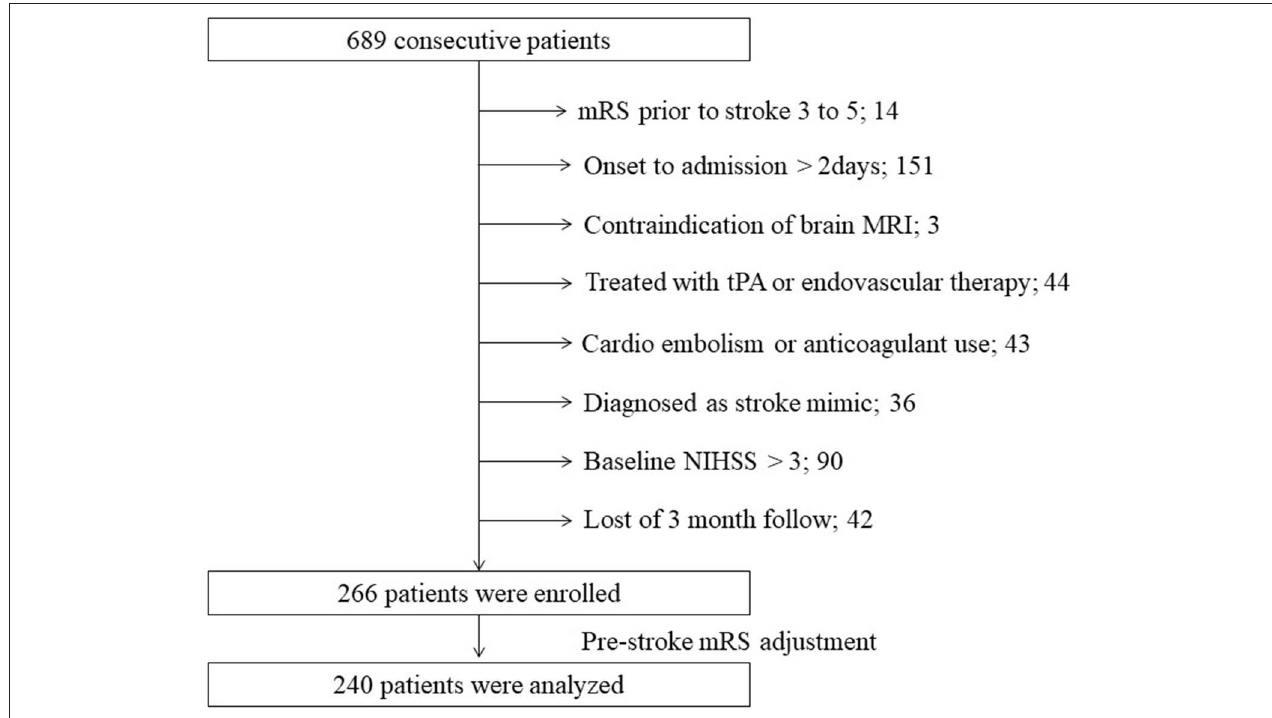
FIGURE 1 | Flow diagram of patient selection. MRI, magnetic resonance imaging; mRS, modified Rankin scale; NIHSS, National Institutes of Health Stroke Scale; tPA, tissue plasminogen activator.